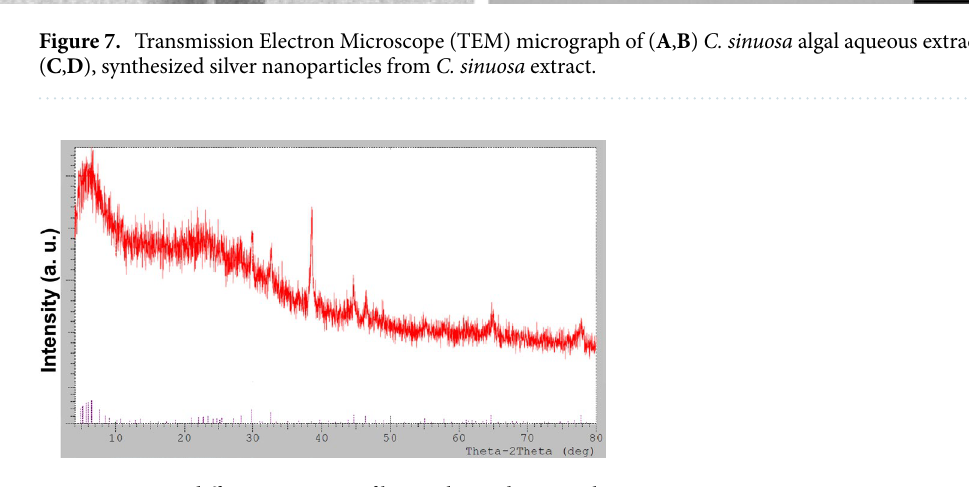
Figure 8. X-ray diffraction pattern of biosynthesized Ag-NPs by C. sinuosa